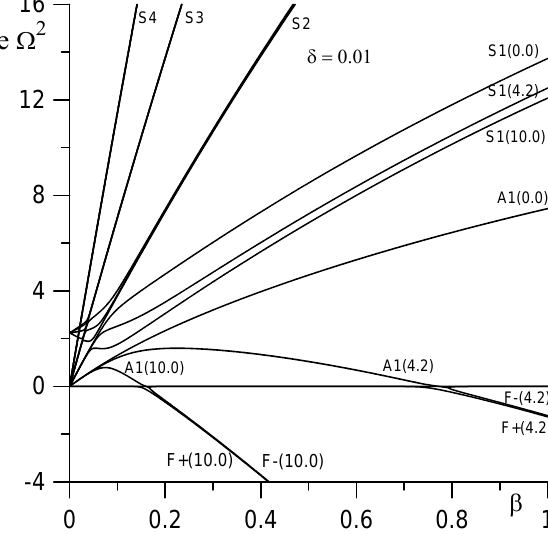
Fig. 6. Dependence of spectrum on beta and profile of pressure for δ = 0 . 01. Captions near the curve indicate the type of eigenmode (“A” – Alfv´en mode, “S” – slow magnetosonic mode, “F” – flute mode), number of eigenmode for periodic modes or growth rate Figure 6. Dependence of spectrum on beta and profile of pressure for 01.0 =δ . Captions near sign for aperiodic modes and value of α in the curve indicate type of eigenmode (“A” — Alfvén mode, “S” — slow magnetosonic mode, “F” — flute mode), number of eigenmode for periodic modes or growth rate sign for aperiodic modes and value of α in parentheses.